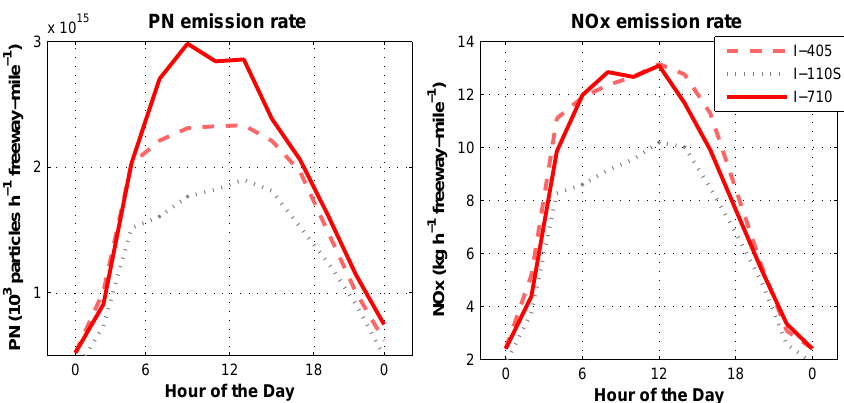
Fig. 4. Diurnal profile of I-110, I-710 and I-405 emission rates. 110S refers to I-110, the southern segment with mixed fuel